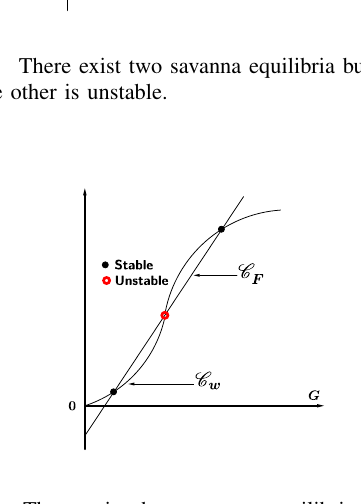
Fig. 9. There exist three savanna equilibria two are stable and one is unstable. Thus system (1) will converge to one of the two stable equilibria depending on initial